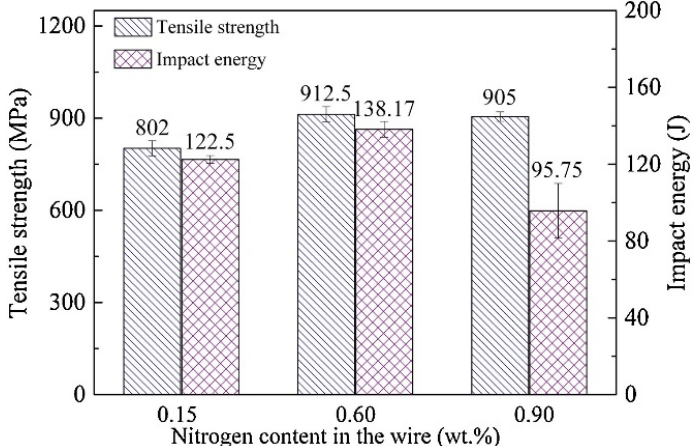
Figure 13. Effect of the nitrogen content in the welding wire on the tensile strength and impact energy. Reprinted with permission from ref. [27]. Copyright 2021, Elsevier.